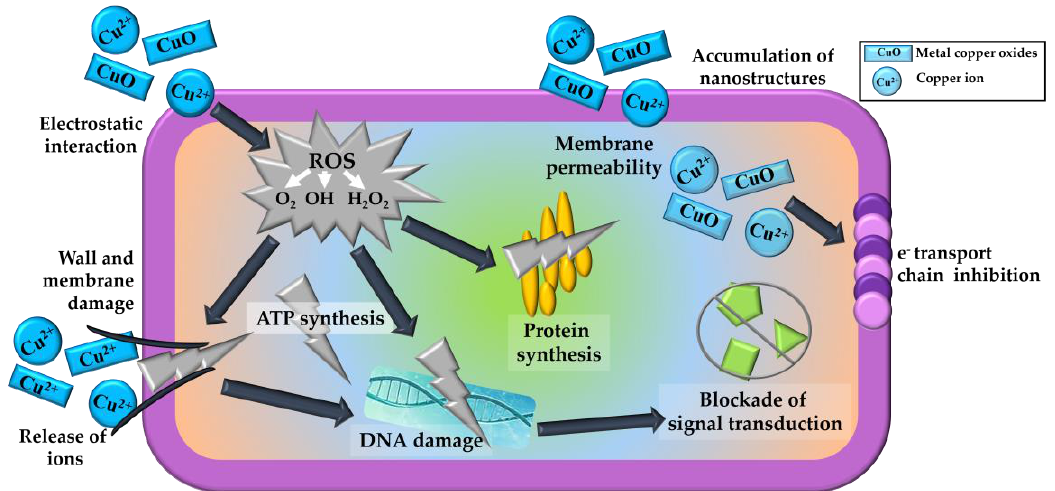
Figure 1. Scheme of theories of the bactericidal effects of nanostructured metal oxides and ions. Adapted from Vázquez-Olmos et al., 2018 [19].